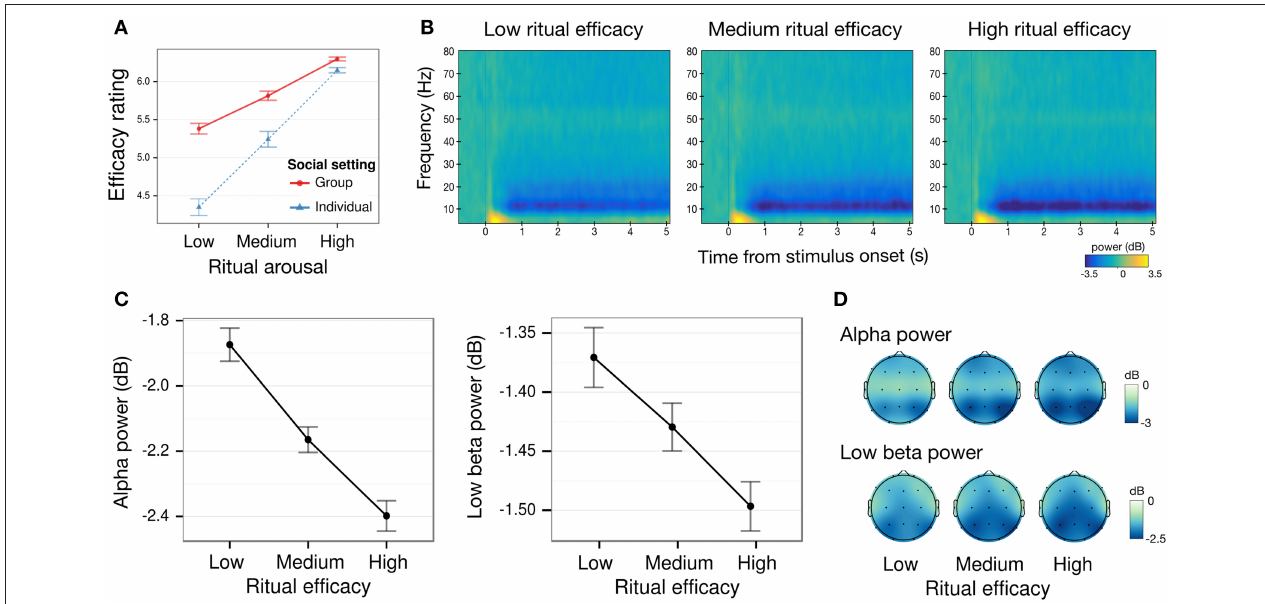
FIGURE 2 | Behavioral and oscillatory power correlates of the perceived efficacy of Chinese spirit-medium rituals. (A) Mean behavioral ratings of perceived ritual efficacy by arousal and social setting. Emotionally arousing rituals were rated as significantly more efficacious. Efficacy ratings for low arousal rituals were marginally higher when viewed in a group of three participants than individually. (B) Time-frequency plot of mean power changes from baseline for low, medium, and high efficacy rituals. (C) Mean alpha (8 – 12Hz) and low beta (13 – 20Hz) power decrease from baseline over all electrodes by perceived ritual efficacy, showing decreasing power for increasing efficacy (1 – 5s post-stimulus onset window) (D) Alpha and low beta power topography (1 – 5s post-stimulus onset window). All error-bars indicate within-participant standard error of the mean. Where there was no significant difference between individual and groups settings, their data were aggregated before